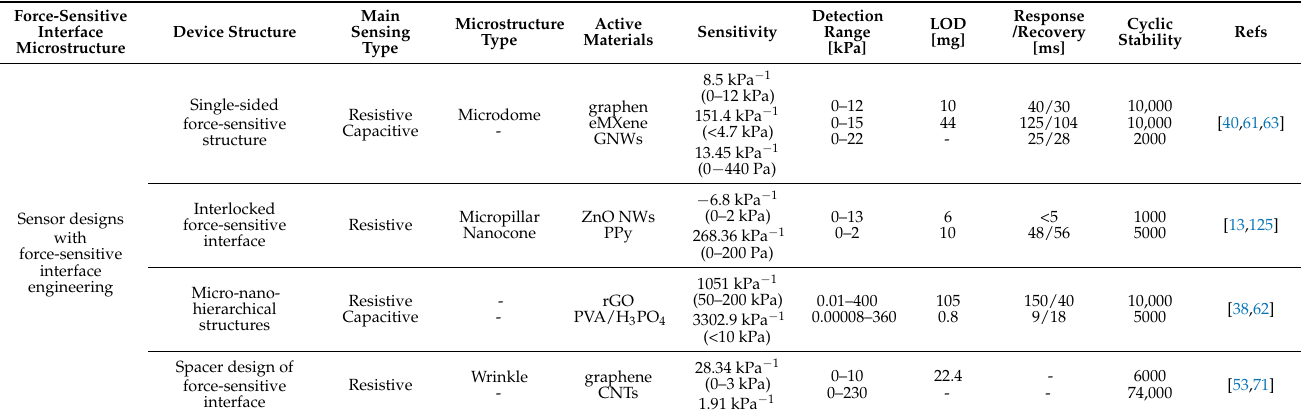
Table 2. Summary of some flexible pressure sensors with different device structures and their performance indicators.